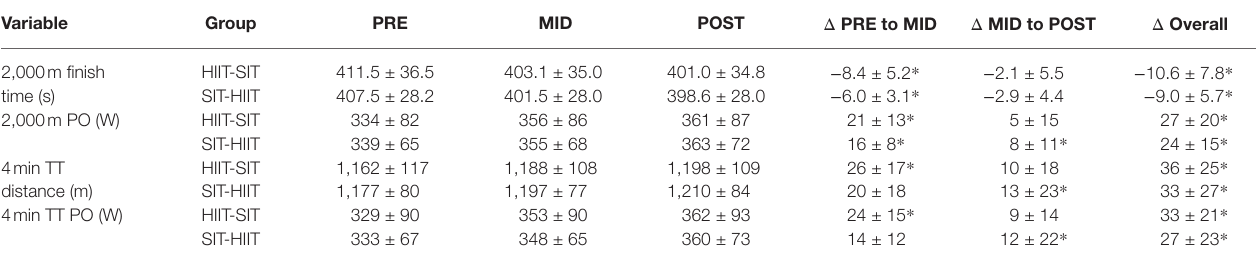
TABLE 2 | HIIT-SIT and SIT-HIIT results for 2,000 m rowing ergometer performance (2,000 m) and incremental step test peak performance (4minTT) for PRE, MID, and POST.